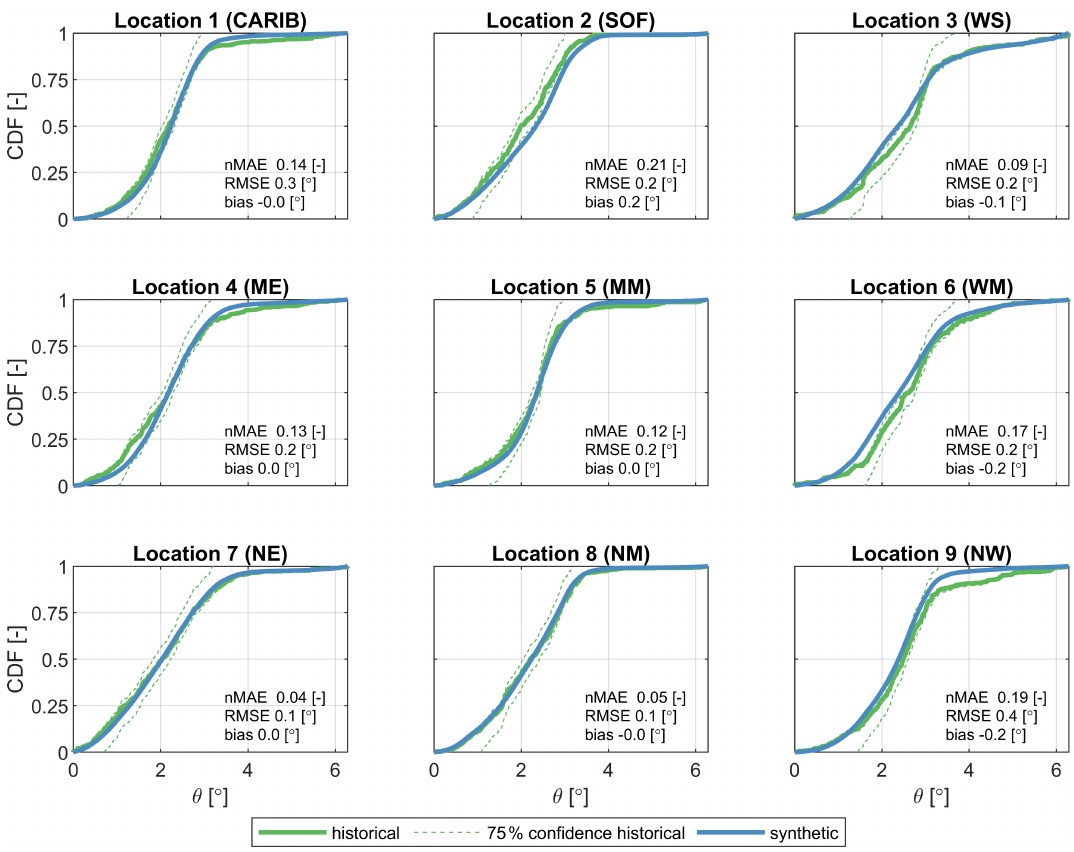
Figure 7. CDFs of heading ( θ [ ◦ ]) of historical (green line) and synthetic (blue line) TCs at 9 locations within the NA basin, as shown on the map in Fig. 2. The 75% confidence interval (dashed green line) of historical data is also shown. Historic data are based on data available between 1886 and 2019, while synthetic data are derived from 10000 years of simulated events with TCWiSE. Data points within 200km from the control location are included in the analysis for both the historical and synthetic